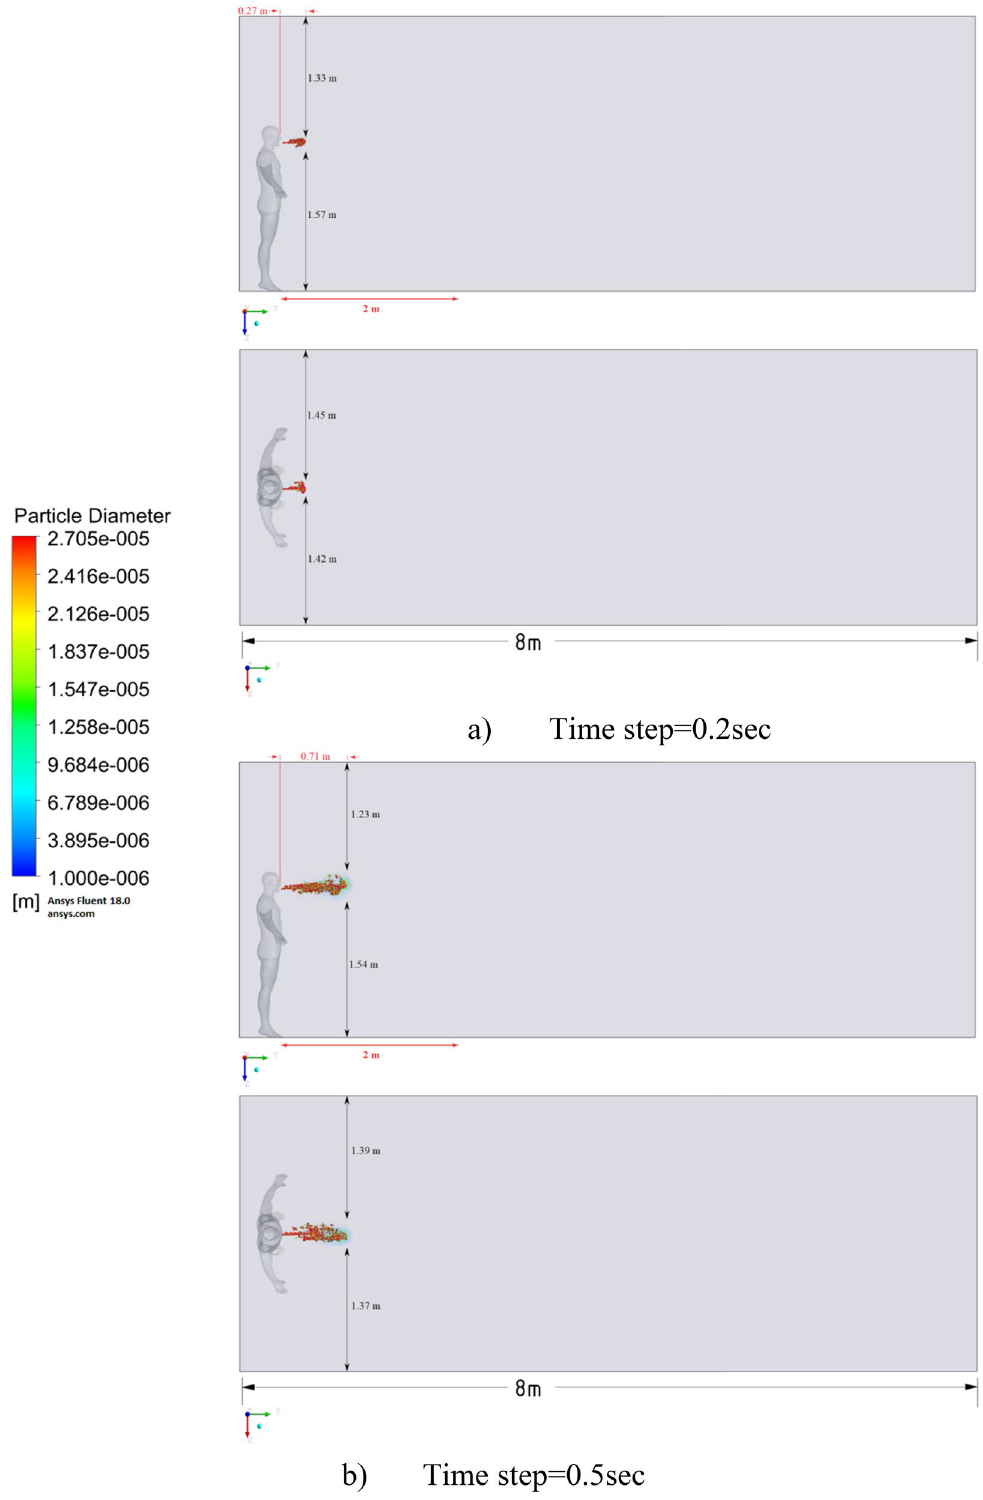
Figure 11. Distribution of the particles for cough = 20 m/s without